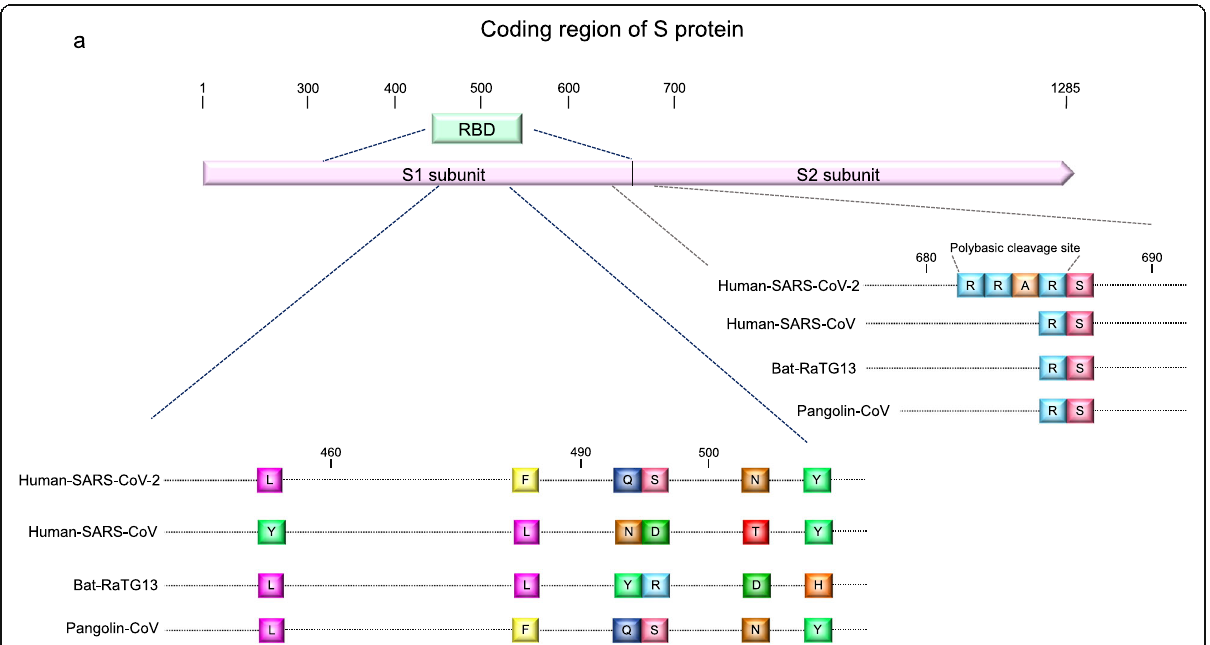
Fig. 2 Consideration of the origin of SARS-CoV-2; common sequence of various coronaviruses and SARS-CoV-2. a The RBD within the S1 subunit has a common amino acid sequence between SARS-CoV-2, RATG13, and Pangolin-CoV. The cleavage site has an amino acid sequence (RRAR) unique to SARS-CoV-2. (Modified from Andersen et al.